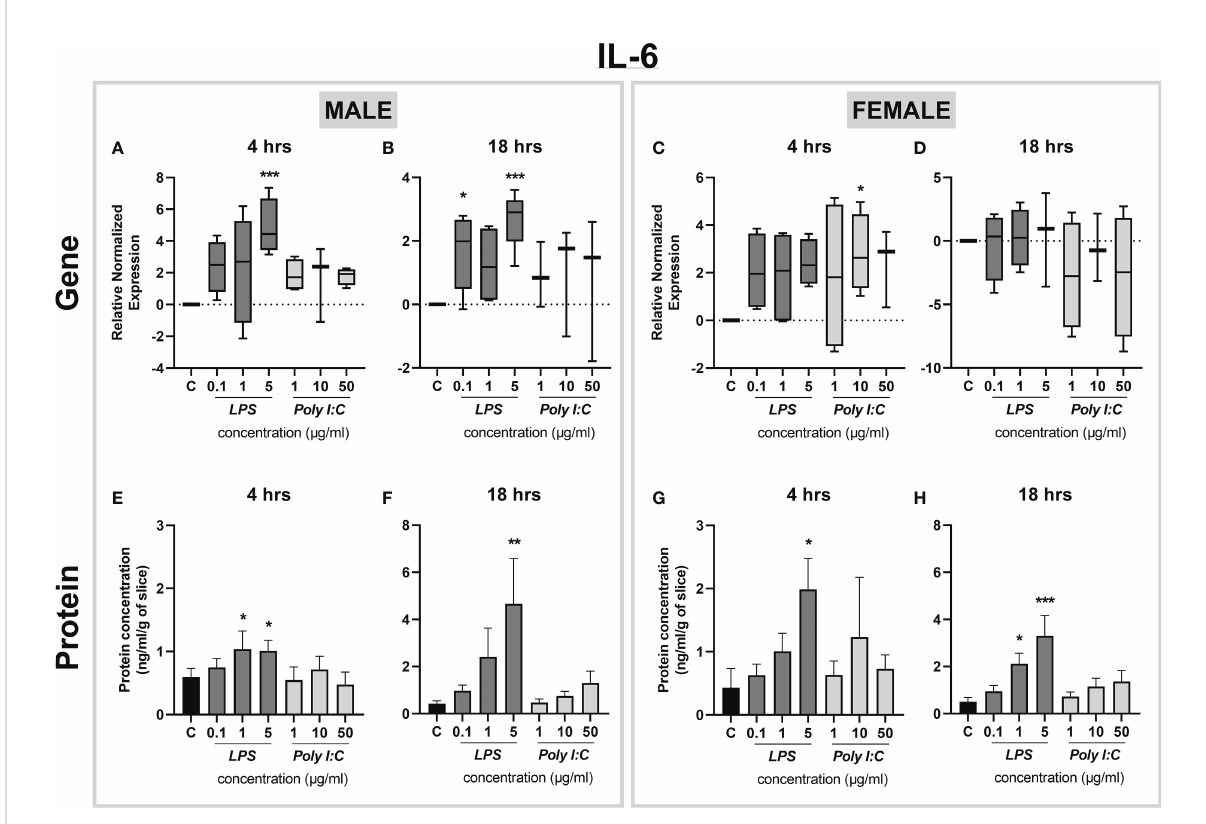
FIGURE 4 Effect of LPS and Poly I:C on IL-6 gene expression and protein concentration. Male and female placental slices were exposed to LPS and Poly I: C at various concentrations for 4 and 18 hours. Gene expression of Il-6 in placental slices was determined by qPCR analysis (A-D) . IL-6 protein concentrations were measured in culture media using a commercially available ELISA kit (E-H) . Data are shown as Tukey boxplots or mean ± SEM; n ≥ 3. *P < 0.05; **P < 0.01; ***P <